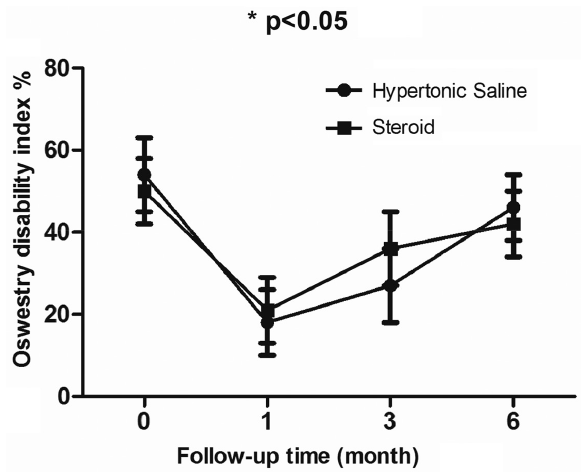
Figure 2. Comparison of proportion (percent) of patient with NRS<3 to total number of patients (25 cases) in each group. Figure 3. Comparison of disability index (ODI %) between two